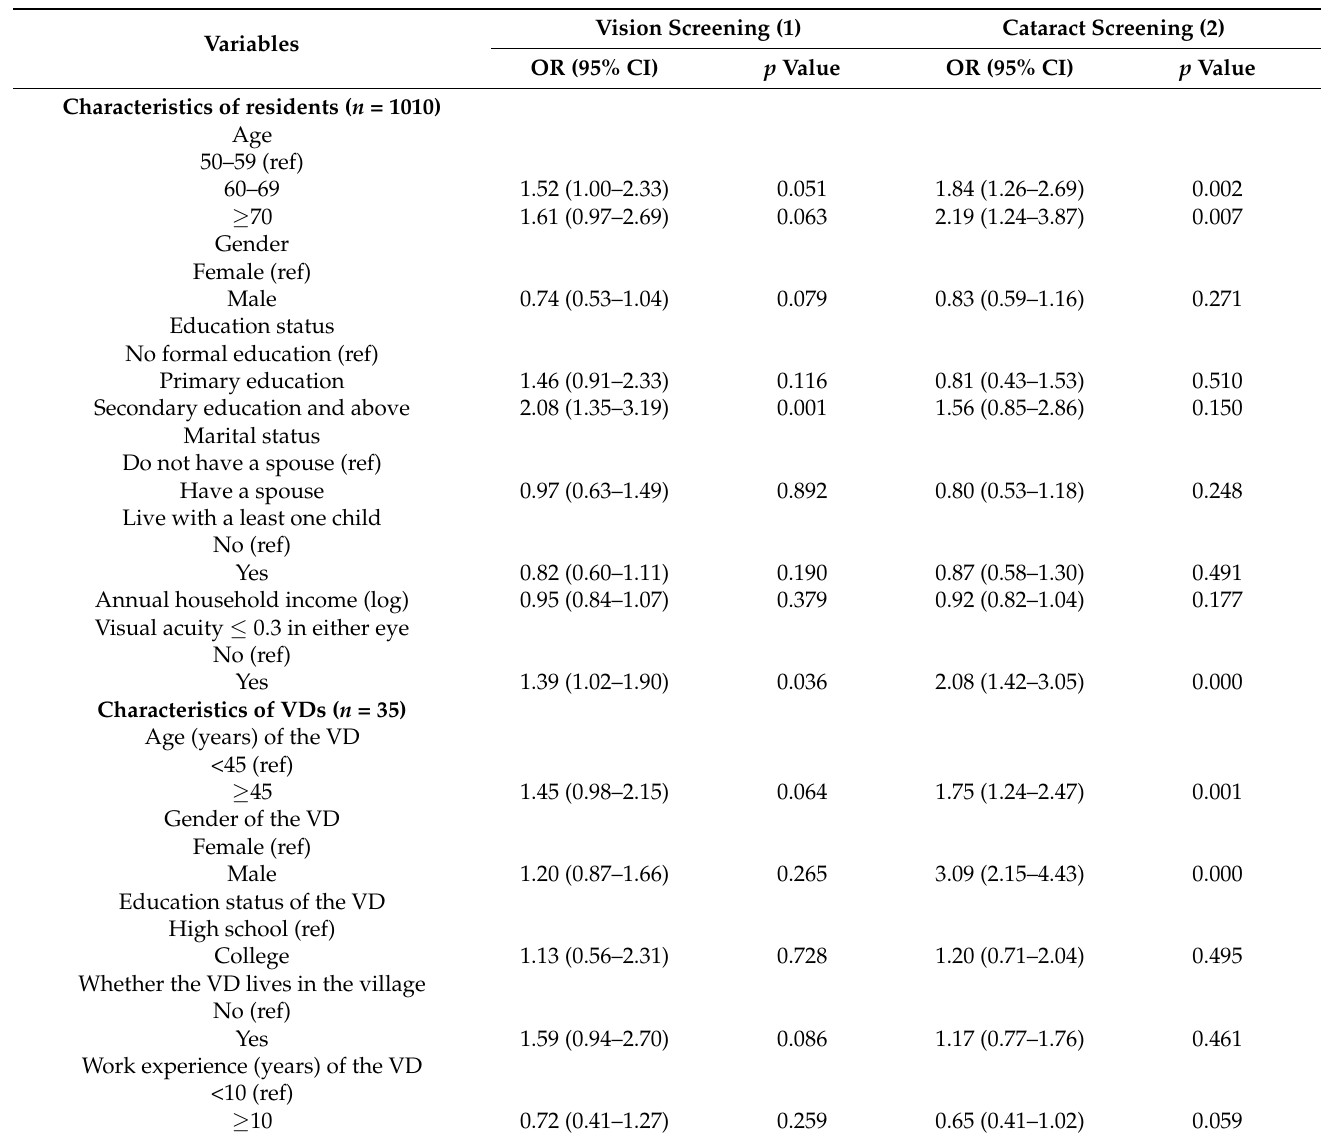
Table 3. Determinants of residents’ uptakes of services for eye screening: vision screening and cataract